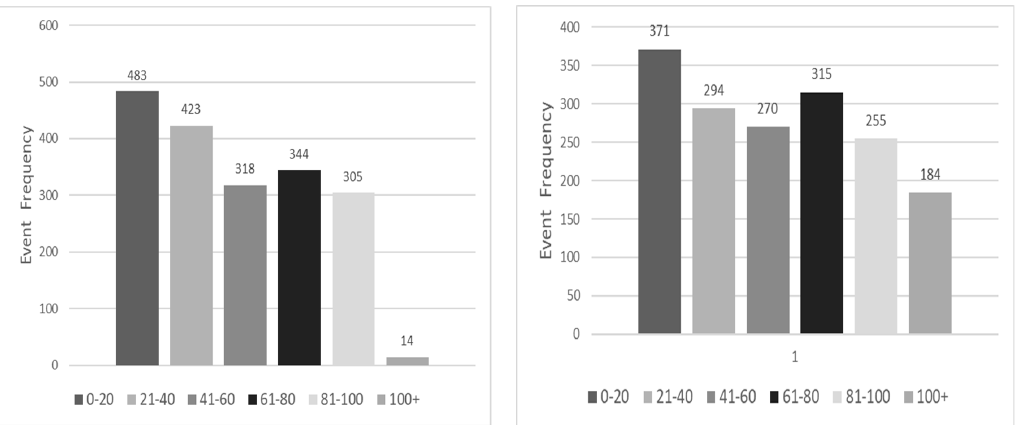
Figure 16. Distribution of terrorism events with respect to Casualty Count ( left ) and Injury Count ( right ), collectively for all events, from 1988–2012. ( right ), collectively for all events, from